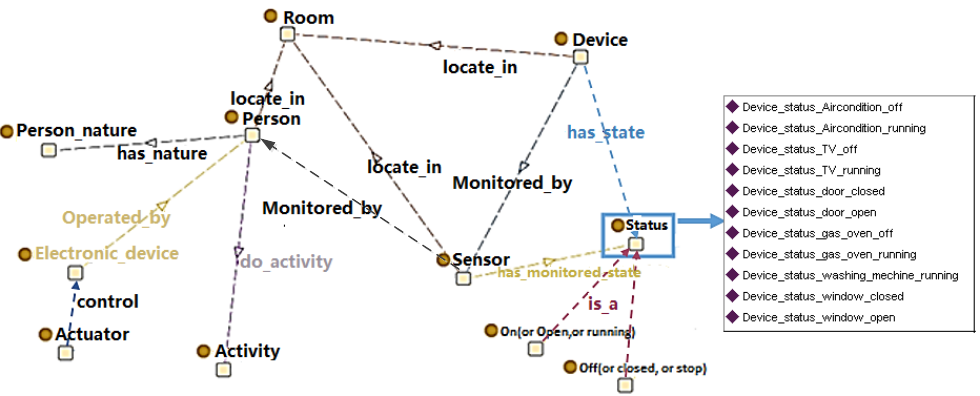
Figure 4. Ontology view focusing on home context knowledge. Table 1. Some property relationships between relevant classes from a home context perspective.